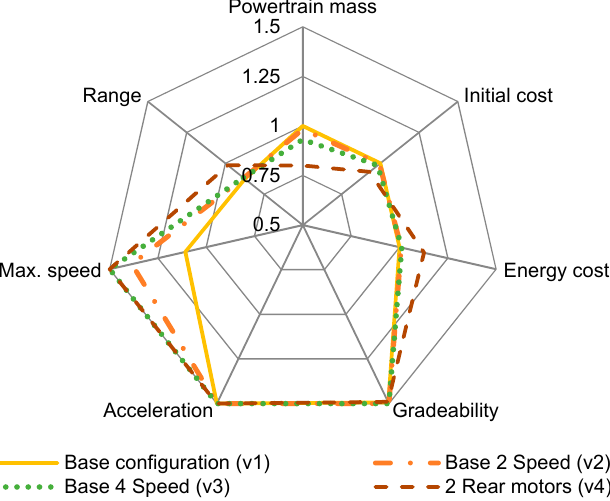
Figure 10. Vehicle characteristics of versions 1–4.